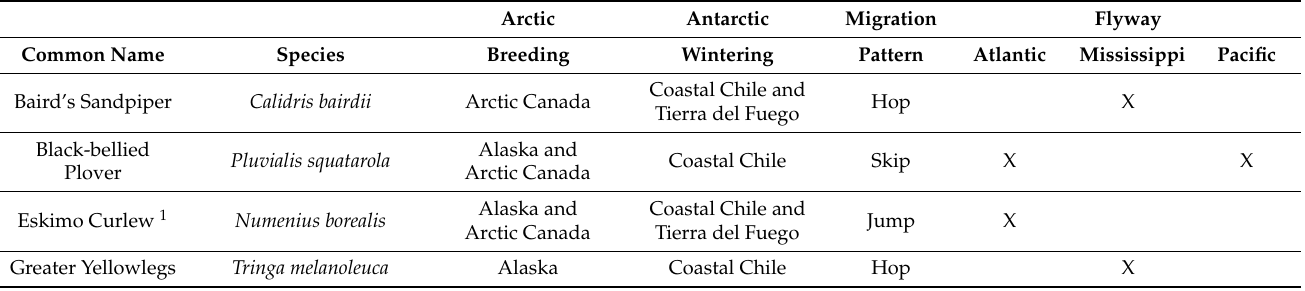
Table 2. Flyways and migration patterns of the bipolar shorebird migrants. Sources—Atlas of Bird Migrations (Elphick, 2011), the Cornell Birds of the World (https://birdsoftheworld.org/bow/home (accessed on 21 December 2021) and The Birds of Chile (Jaramillo, 2013). Arctic n